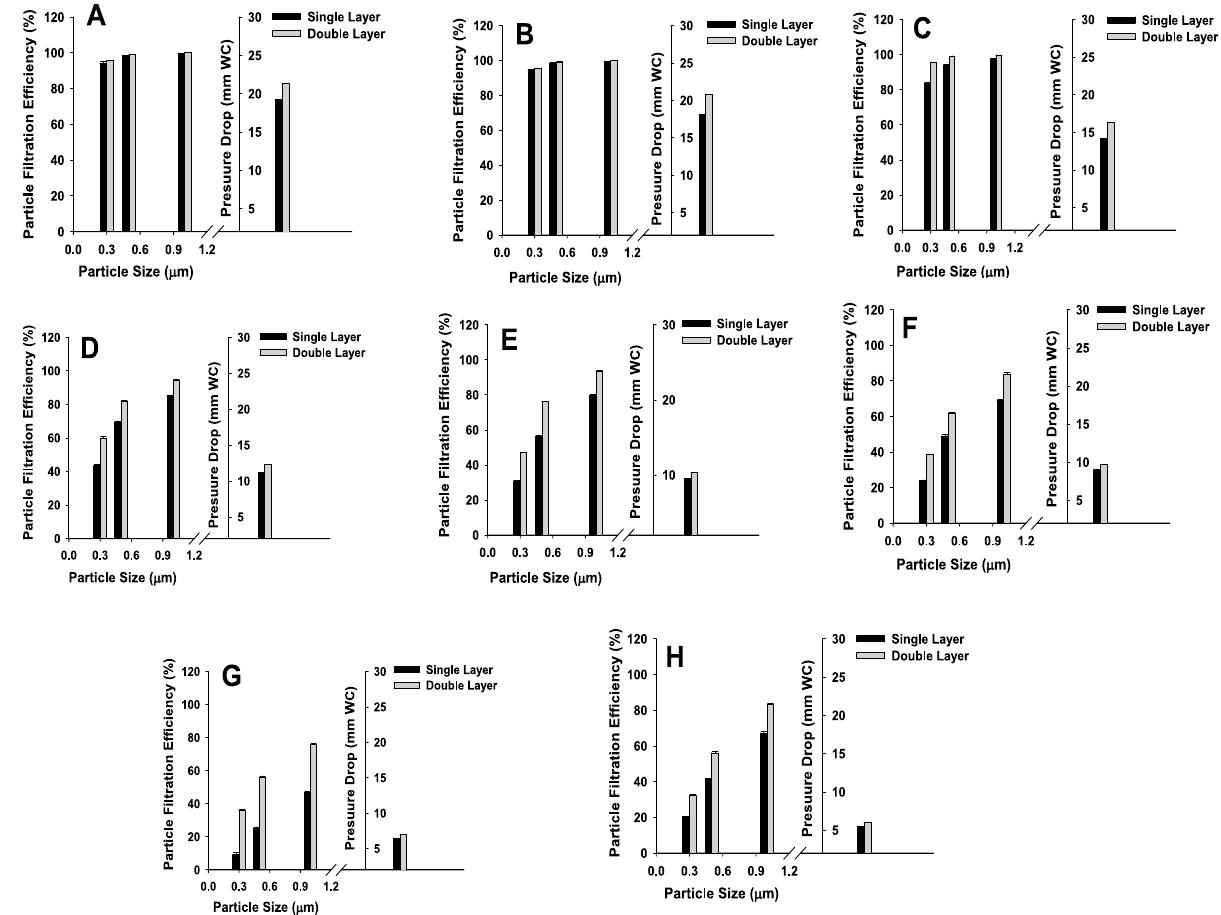
Figure 5. Particulate filtration efficiency and pressure drop of various PP-MB-NW fabric sample (A–H) in single and double layers: Fig. 5A–H: PFE of sample A, B, C, D, E, F, G and H in single and in double layer against NaCl aerosol particle size 0.3, 0.5 and 1 µm. The error bars represent the standard deviation of three